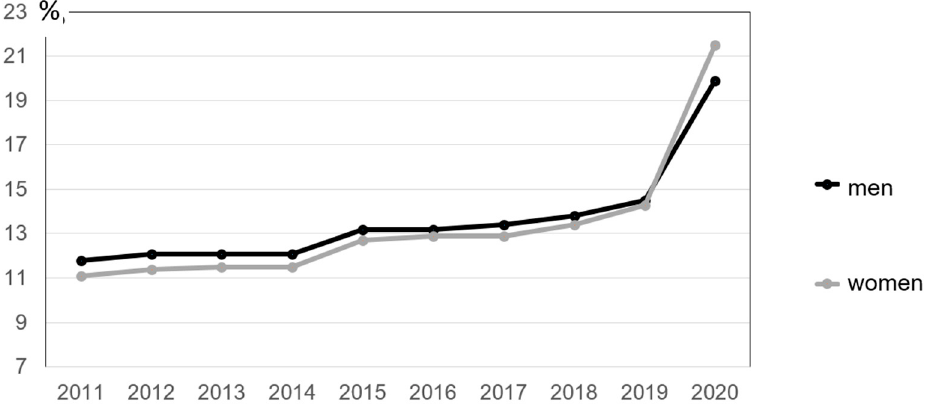
Figure 2. Shares of employed men and women working from home (occastionally and usually). Source: [59], own calculations.